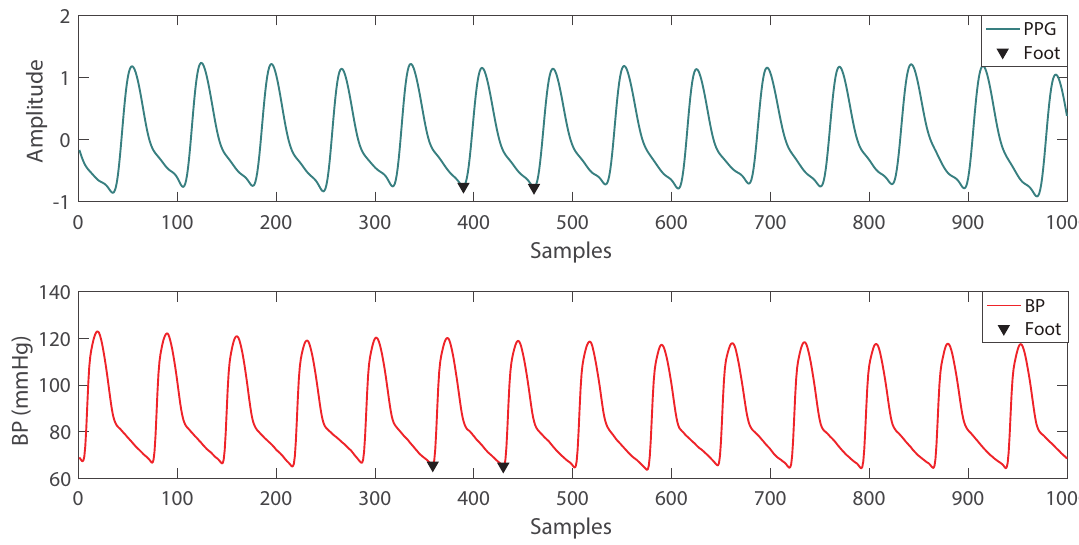
Figure 3. Example of single-period waveform extraction: the waveform between the two feet is extracted.